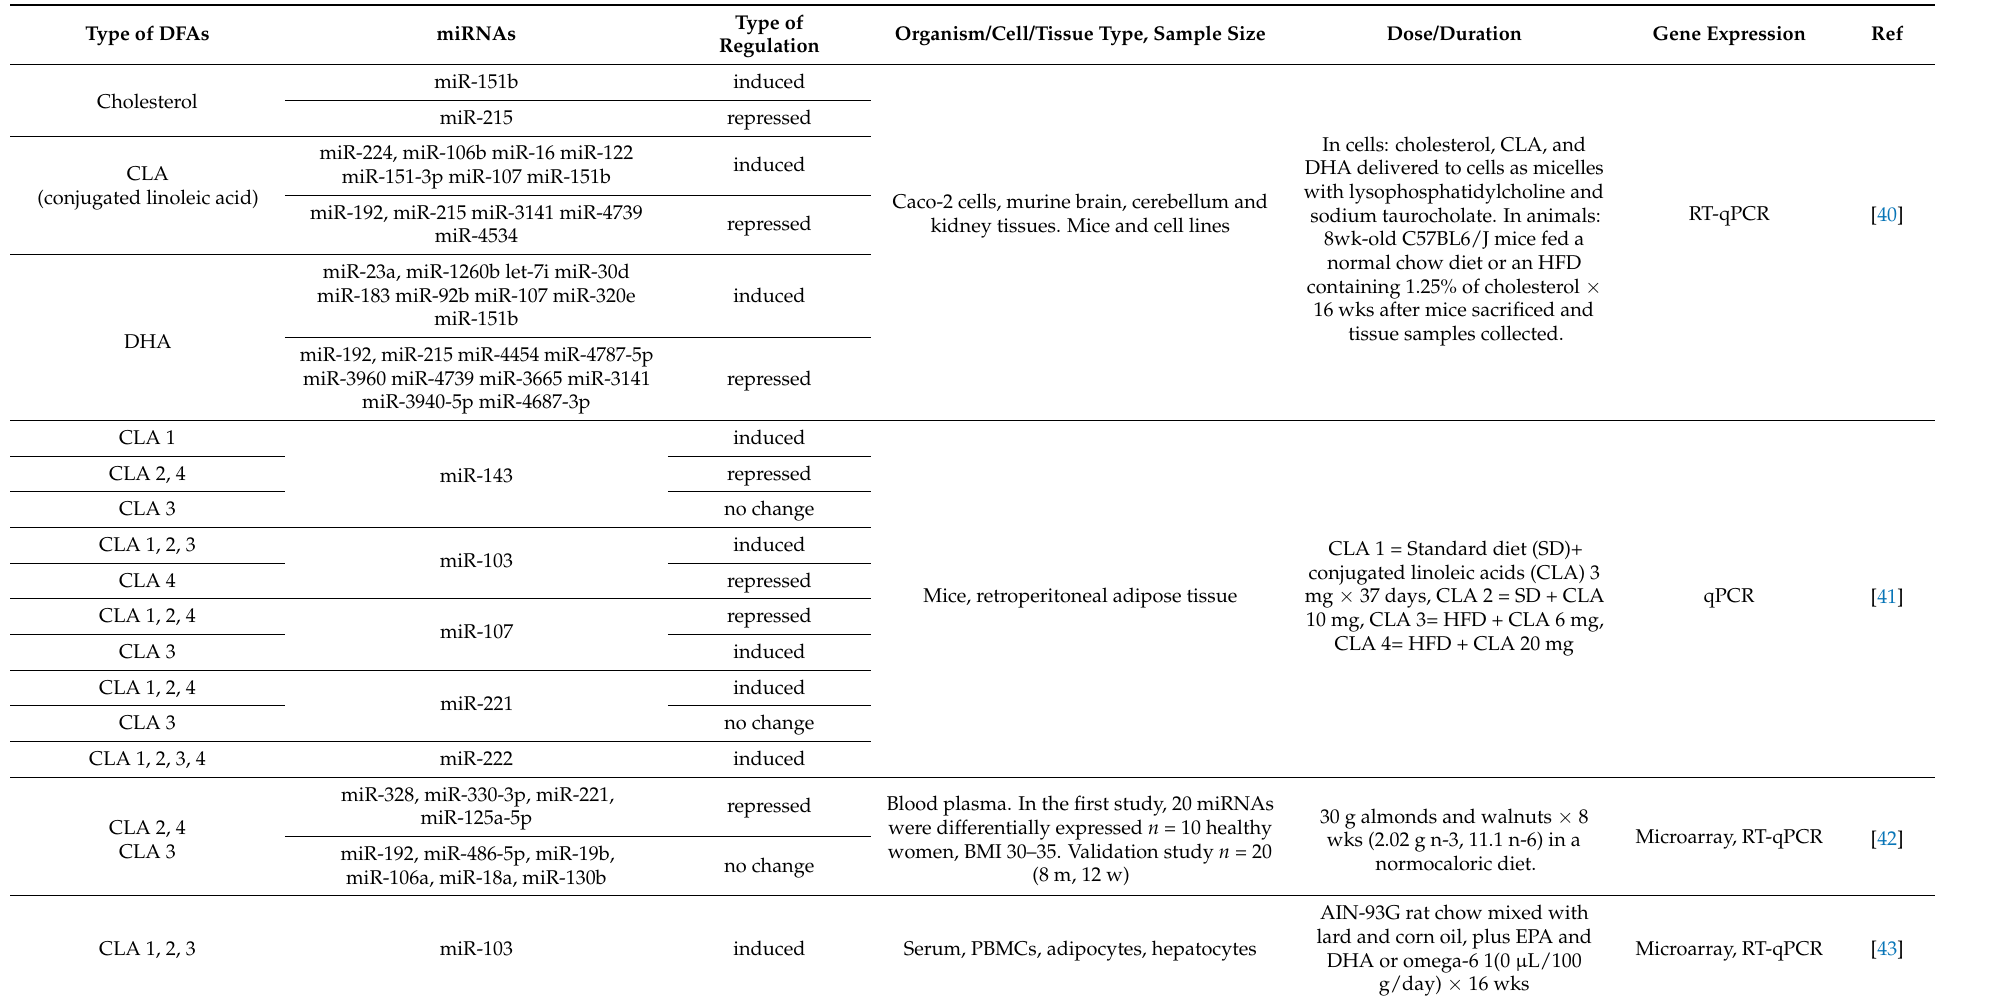
Caco-2 cells, murine brain, cerebellum and kidney tissues. Mice and cell lines